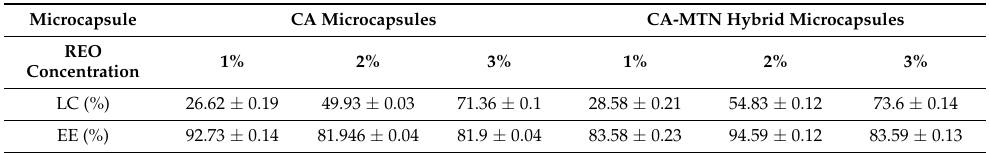
Table 4. Loading capacity (LC) and encapsulation efficiency (EE) for CA and hybrid CA-MTN